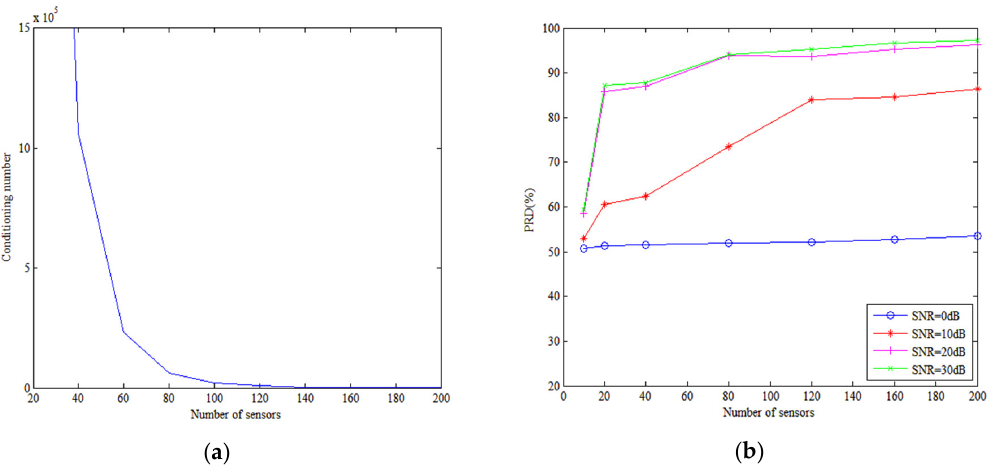
Figure 6. Conditioning number and performance evolution with the number of sensors for different SNRs. The tested number of sensors ranges from 10 to 200, and SNR is 0, 10, 20, and 30 dB. ( a ) Conditioning number of matrix F versus number of sensors. ( b ) PCD versus number of sensors.